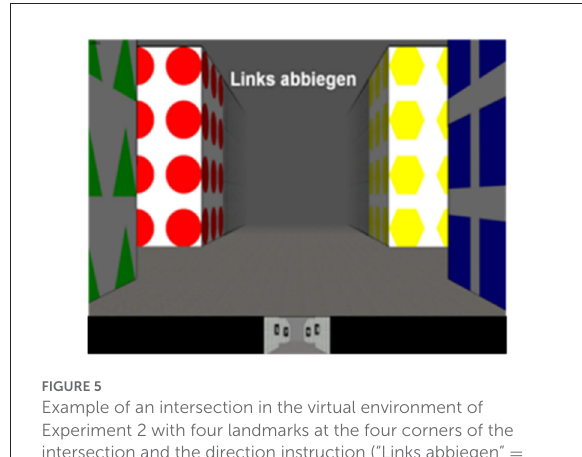
FIGURE5 Example of an intersection in the virtual environment of Experiment 2 with four landmarks at the four corners of the intersection and the direction instruction (“Links abbiegen” = turn left).